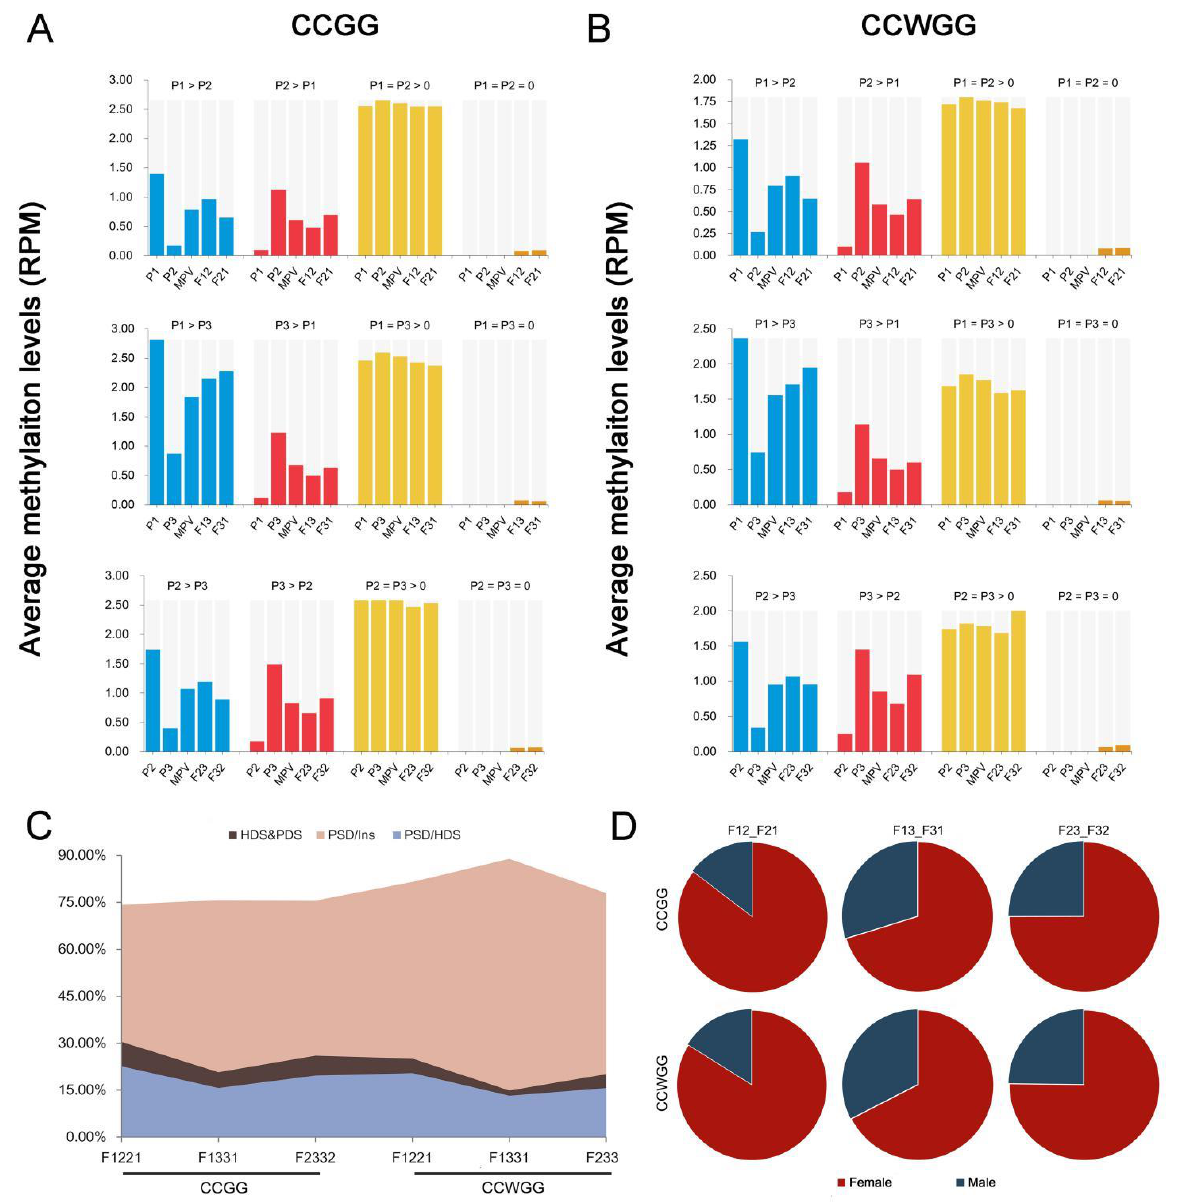
Figure 2. Association of DNA methylation in reciprocal hybrids with parental methylation status. ( A , B ) Average methylation levels at three combinations in developing seeds. Four groups are classified based on parental methylation differences in two cytosine contexts, including one parental line higher methylated than another parental line (e.g., P1 > P2 or P2 > P1); both parents are methylated with equal methylation levels (e.g., P1 = P2 > 0); cytosine contexts showing no methylation in two parents (e.g., P1 = P2 = 0). ( C ) Association of DNA methylation in reciprocal hybrids with parental-unequal methylated sites. HDS, reciprocal hybrids differentially methylated sites; PDS, parental differentially methylated sites; HDS&PDS and Ins, intersection ration of HDS and PDS; PSD, parental selective difference sites; PSD/Ins, PSD as a percentage of Ins; PSD/HDS, PSD as a percentage of HDS; F1221/F1331/F2332, the hybrid combination, e.g., F1221 is a combination using P1 and P2 as crossing parents, the same as figure below. ( D ) Parental selective difference sites in reciprocal hybrid’s unequal region. F12_F21/F13_F31/F23_F32, the methylated differential site of reciprocal hybrids, e.g., F12_F21 denotes those sites between F12 and F21.